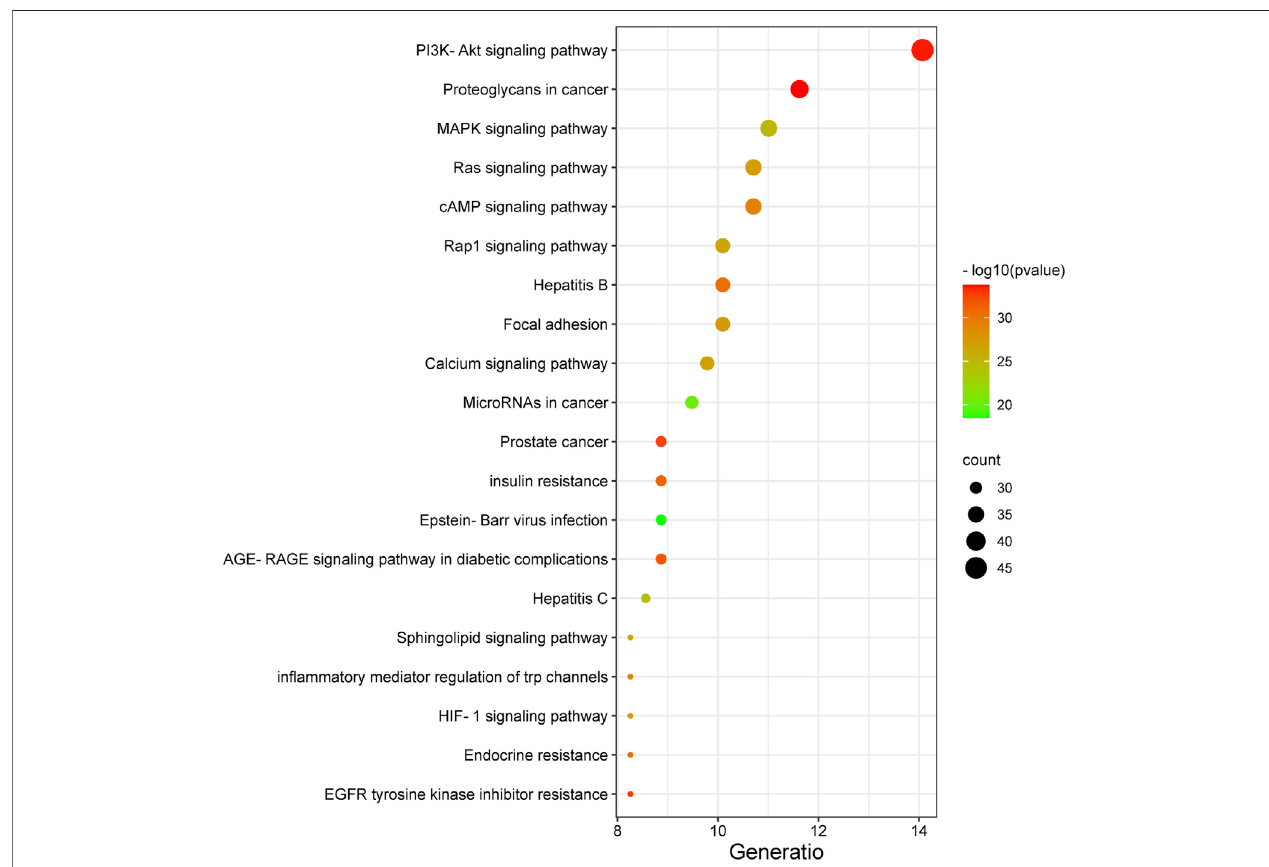
FIGURE 5 | The top 20 pathways identi fi ed by KEGG analysis of the new treatment formulation for ischemic stroke with Qi de fi ciency and blood stasis syndrome. The y -axisrepresentsthename ofeach pathway, and thesizeofthedotscorrespondstothenumber ofgenesannotatedinthepathway. The x -axis represents theratio corresponding to the signi fi cance of the differential protein enrichment, with higher ratios indicating higher